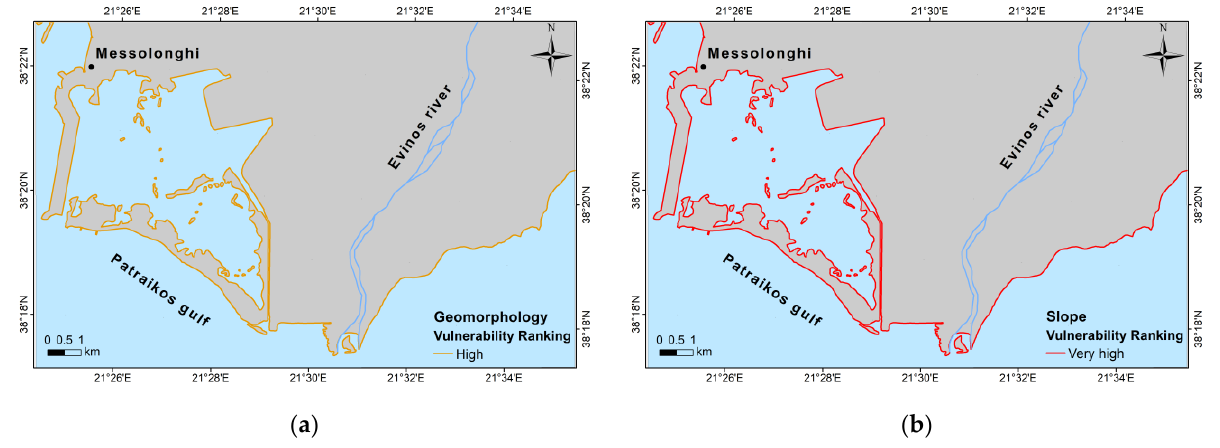
Figure 2. Assigned vulnerability classes in response to ( a ) geomorphology and ( b ) coastal slope.